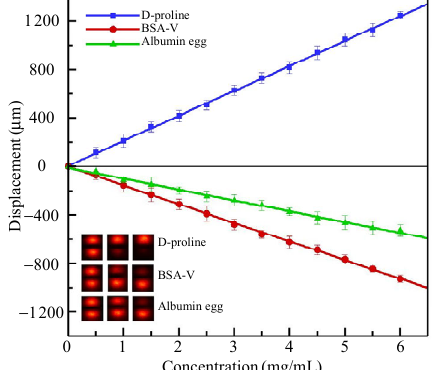
Fig. 4 Results for three samples. The dots are the experimental data. The lines are the fitted curves. Insets exhibit the light spots shown on the CCD of these three samples at the concentration of 0 mg/mL, 0.3 mg/mL, and 0.6 mg/mL from left to right,